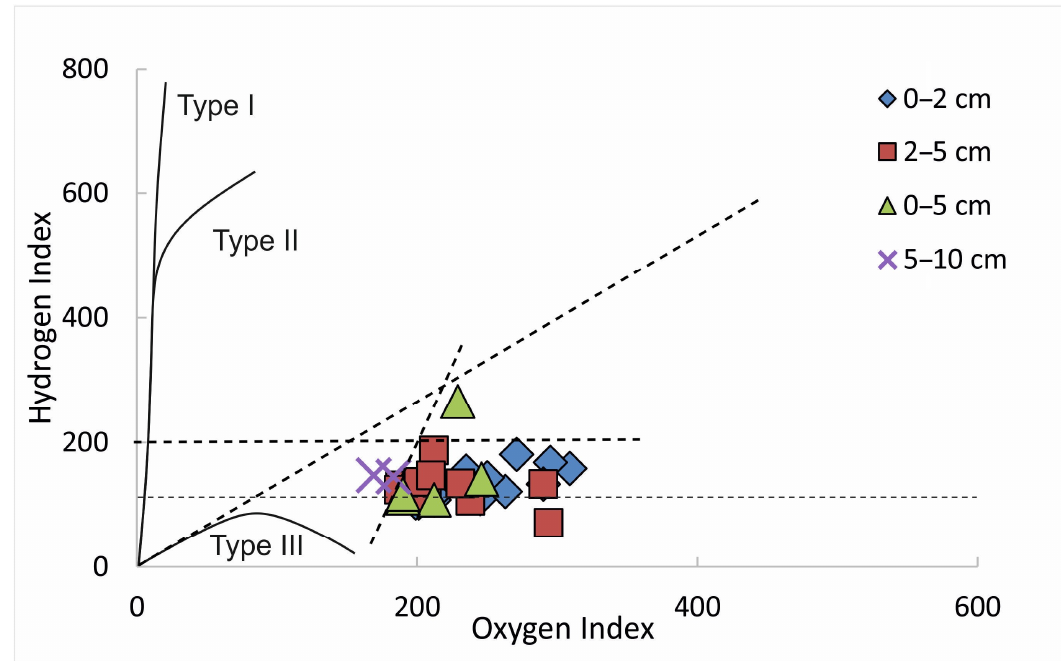
Figure 2. Van Krevelen-type diagram of surface sediments in LS. Each symbol represents one horizon of the sediment core indicated in the legend. Curved lines I, II and III represent kerogen types for the ancient sediments and matured OM (algal/sapropelic, planktonic and humic, respectively). Dashed line represents HI = 100. Bold dashed line represents HI/OI = 1. Blue rhombs, red squares, green triangles and lilac crosses represent different sediment sampling horizons: 0–2 cm, 2–5 cm, 0–5 cm and 5–10 cm, respectively.